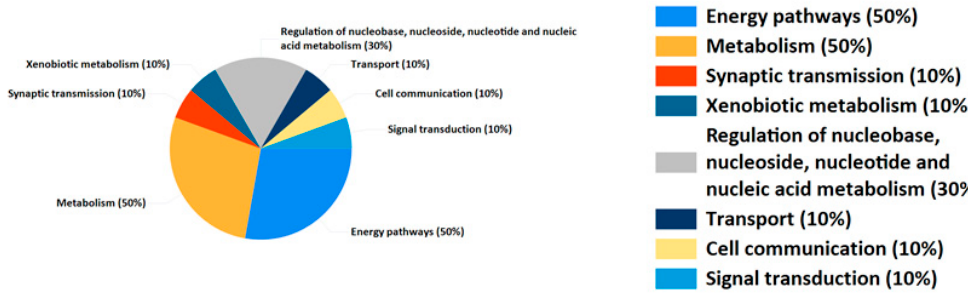
Figure 7. Biological process for merge gene.